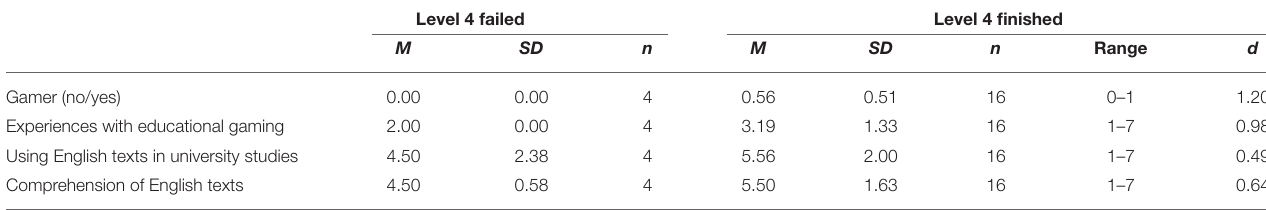
TABLE 9 | Descriptive statistics of the students’ subjective ratings of their learning experience and comprehension of English texts.